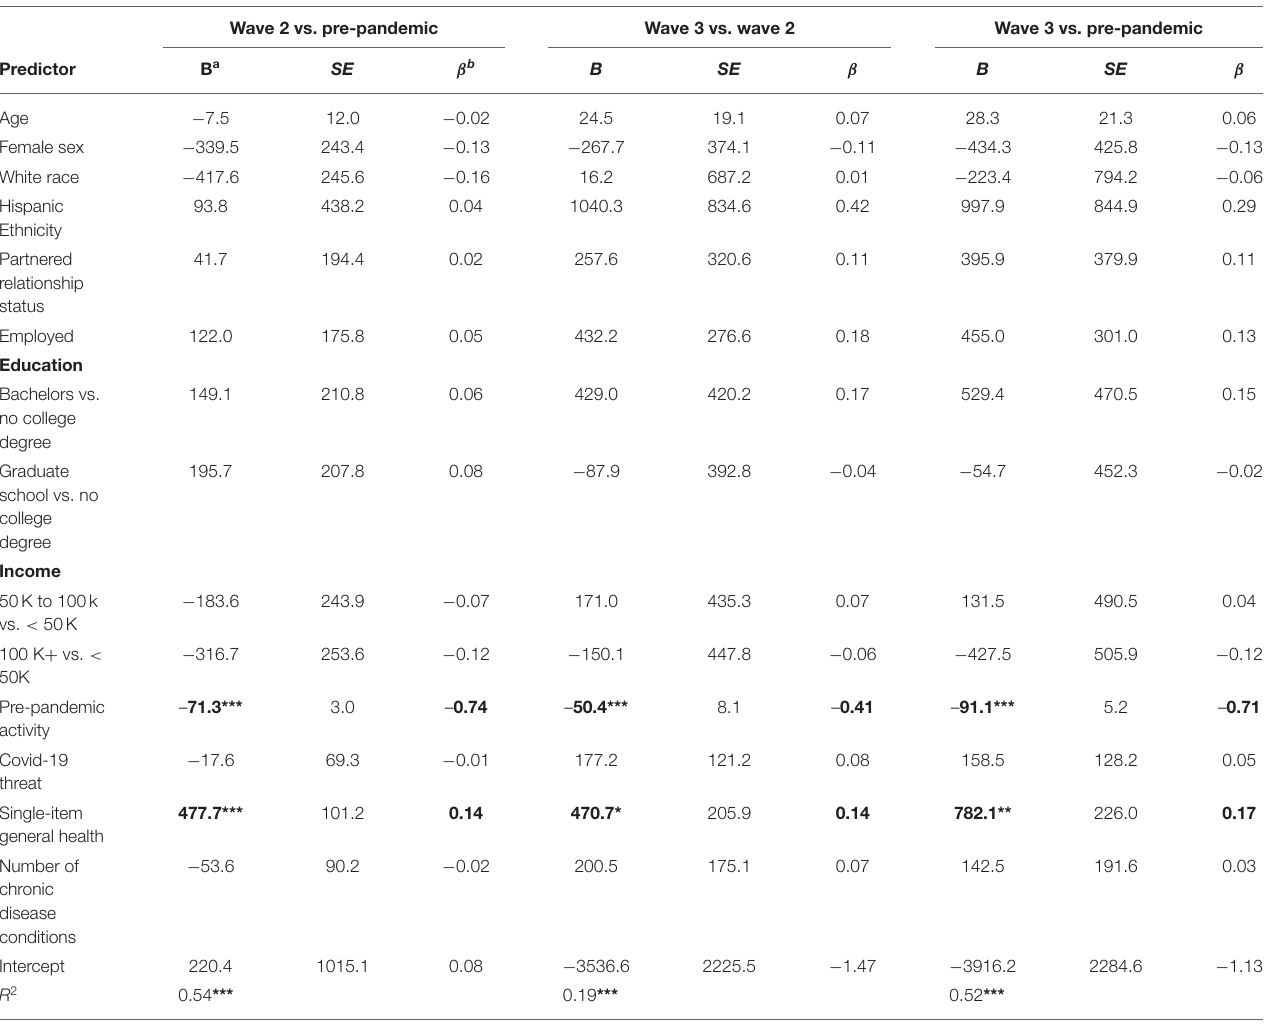
TABLE 3 | Regression results for total MET-min/week of activity change between specific periods. Wave 2 vs. pre-pandemic Wave 3 vs. wave 2 Wave 3 vs.